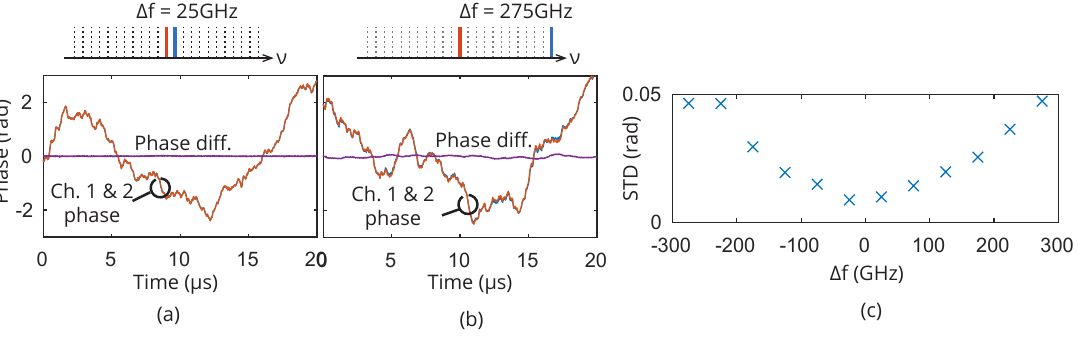
Figure 8. ( a ) Phase traces from channels spaced ∆ f = 25GHz apart, together with their difference; ( b ) phase traces from channels spaced ∆ f = 275GHz apart, together with their difference; ( c ) phase difference standard deviation (STD) as a function of channel frequency